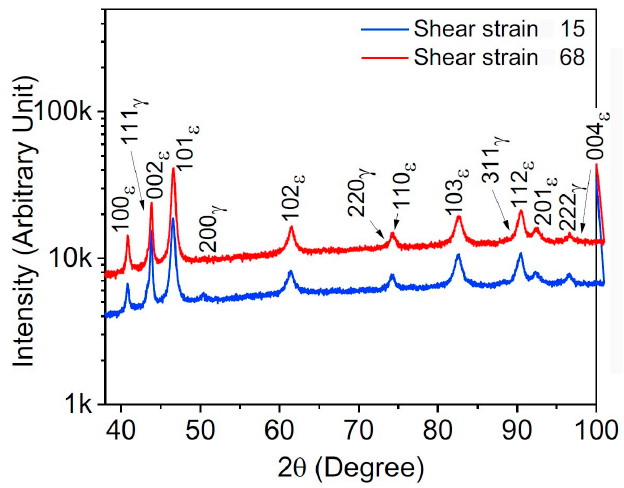
Figure 6. Indexed XRD pattern of HPT-processed specimens at shear strain 15 and 68 showing formation of a significant amount of hcp ε -phase. Reprinted with permission from Ref. [27]. Copyright 2021 Elsevier.